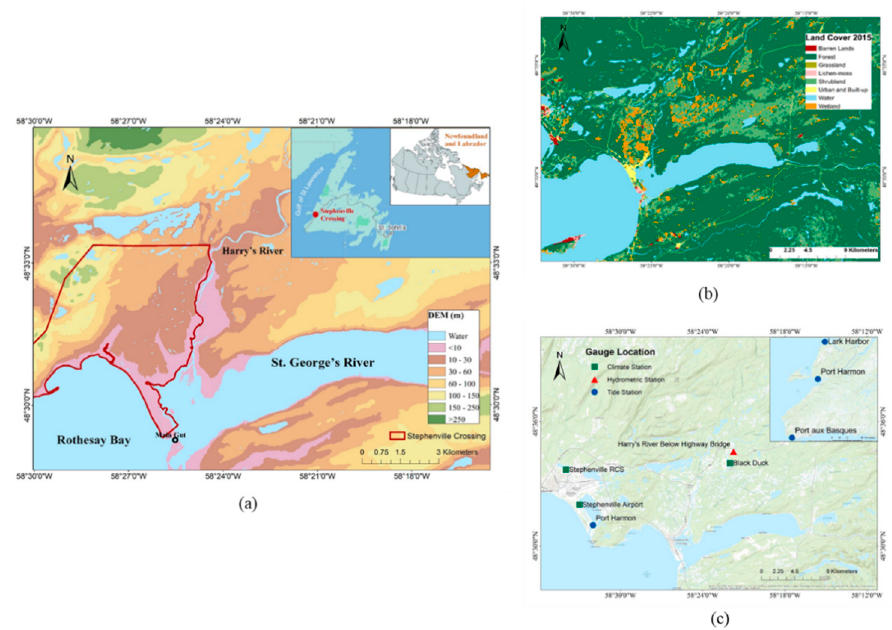
Figure 1. ( a ) Study area including the Town of Stephenville Crossing, ( b ) land cover map, and ( c ) location of available climate (green), hydrometric (red), and tide (blue) gauges.